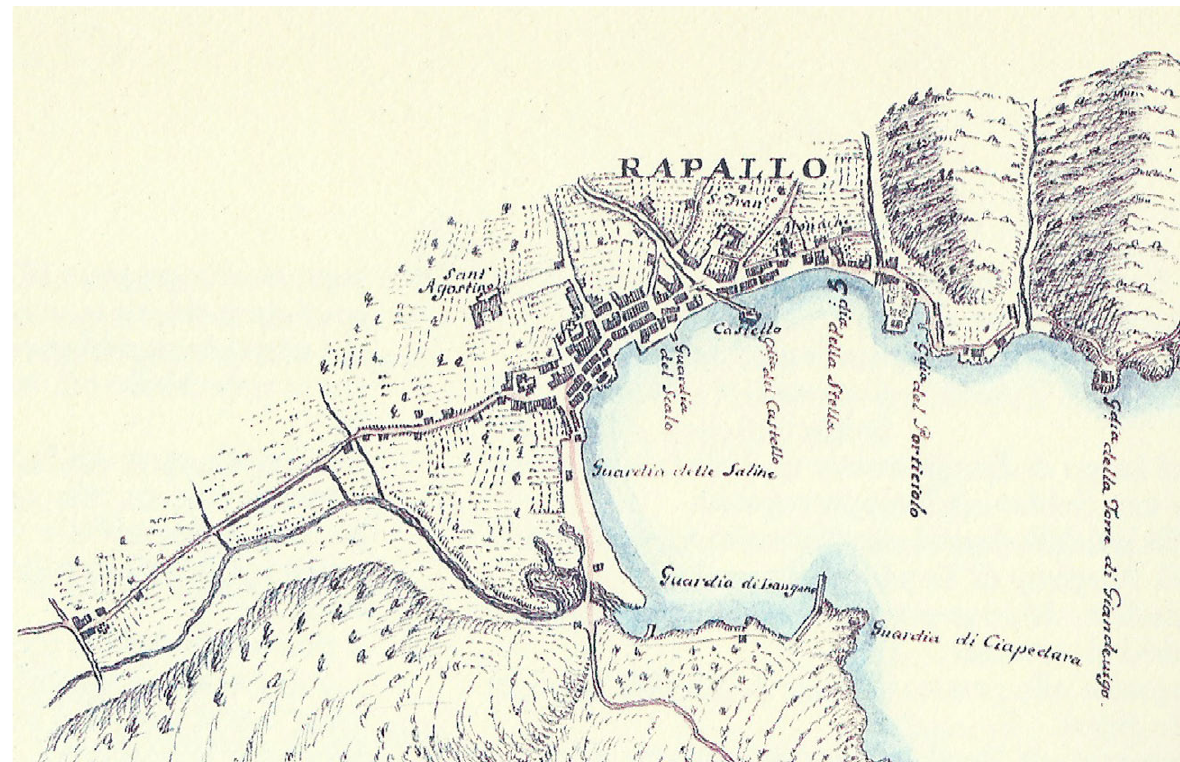
Fig. 4. Rapallo in the early eighteenth century (after Matteo Vinzoni map,